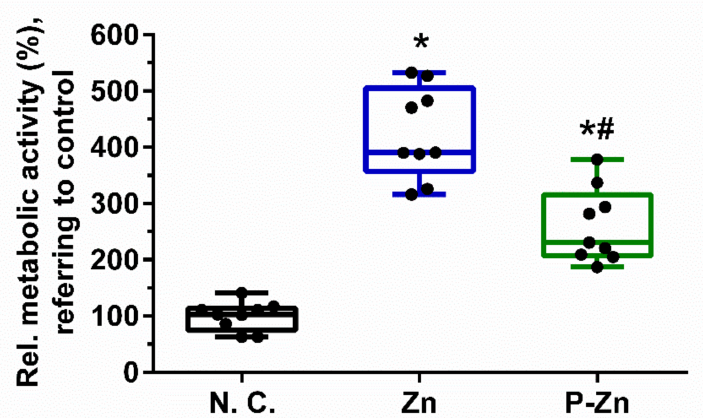
Figure 4. Relative metabolic activity of L929 cells cultured on titanium, zinc and pre-treated zinc for 24 h, measured by CCK-8 assay. A titanium-based alloy was used as a negative control and set to 100%. The box-and-whisker plot indicates the combined results from three independent experiments with three samples per group in each run. Black dots represent each tested sample ( n = 9). * and # represent p < 0.05 when compared to the negative control and pure Zn,